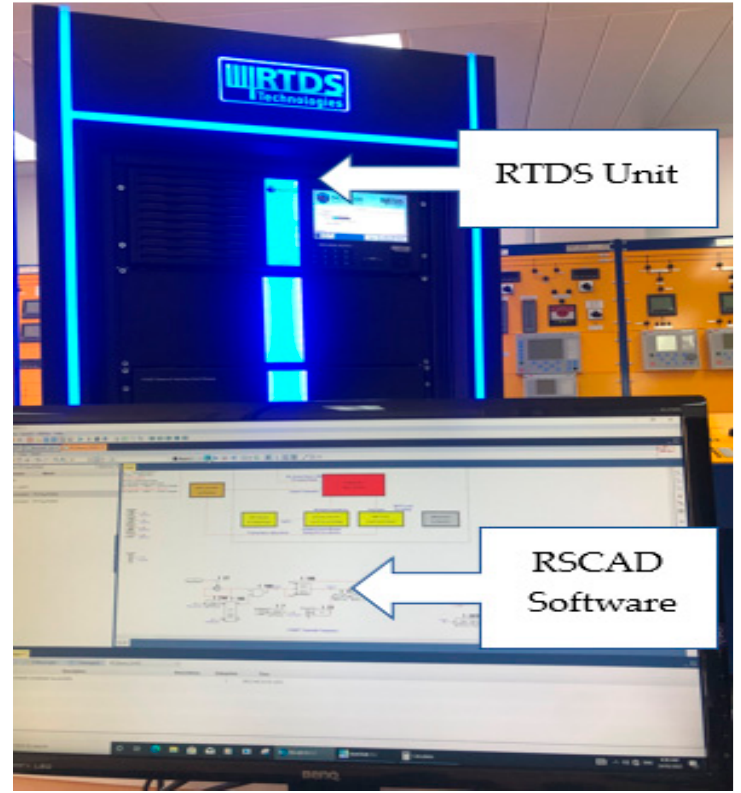
Figure 2. Hardware and software components of the RTDS.